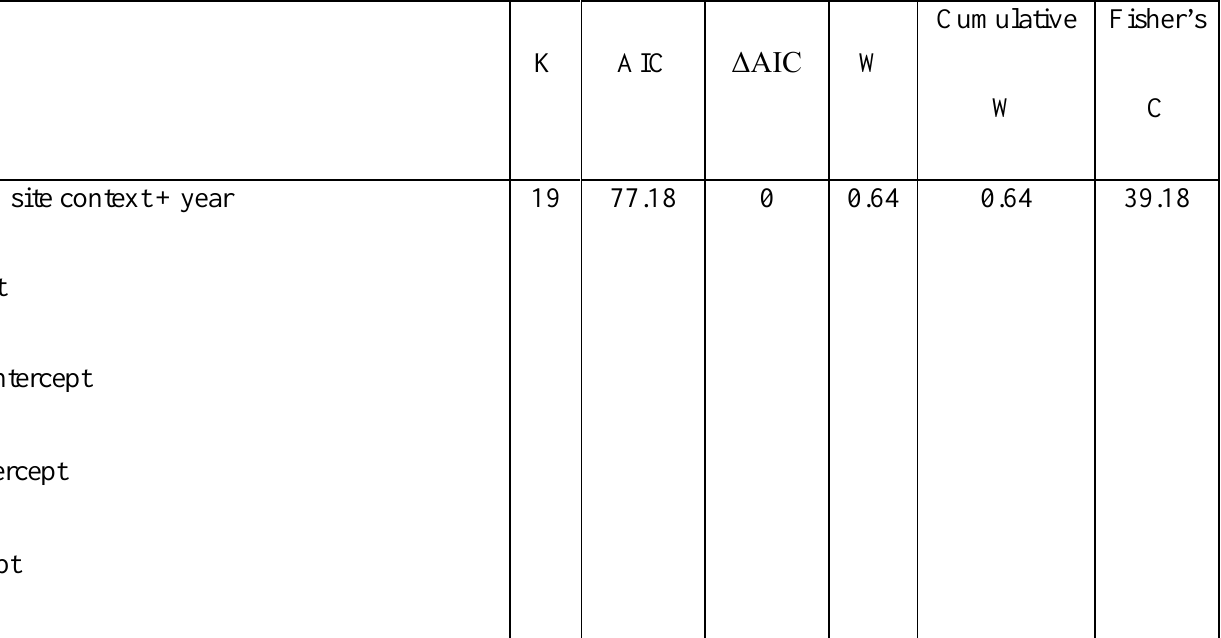
Table A1.3. AIC model selection results for path models examining factors hypothesized to effect kernel density estimates of territory size and breeding success. K represents the number of parameters in each path model. W and Cumulative W represent Akaike weights and cumulative model weights, respectively. Fisher’s C statistic = -2*ln(model likelihood). Path model equations represent individual regression equations or sub-models comprising each path model, where each predictor variable represents a path in the path model. Null model represents the top model with all paths to territory size and breeding success removed. ⱡ indicates random effect included in sub-model for study